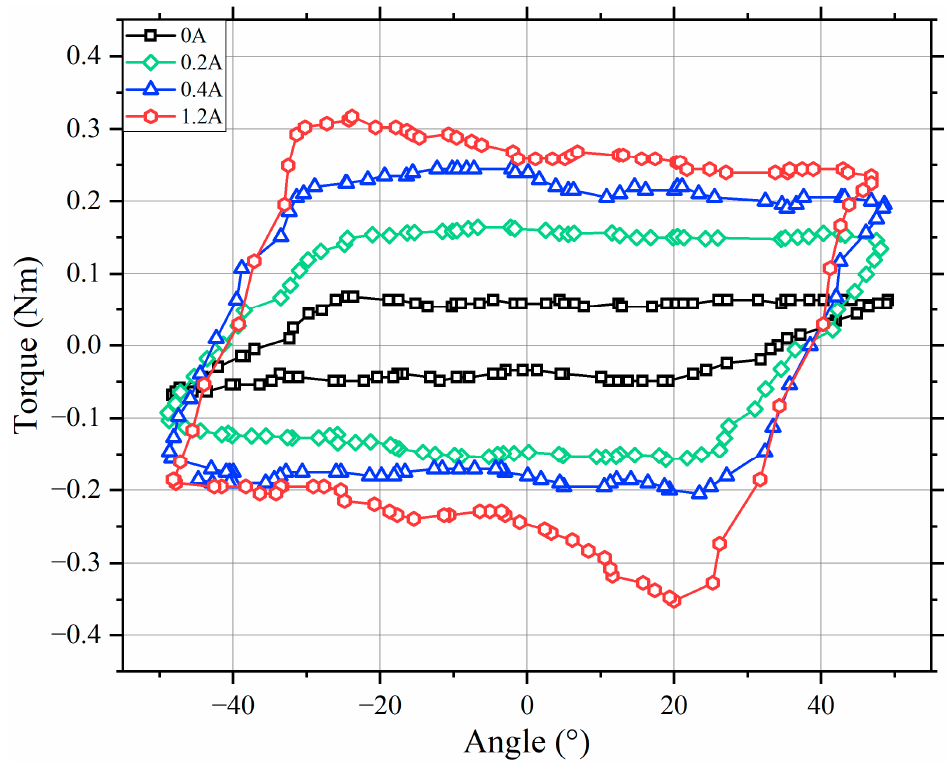
Figure 8. Torque–angle curve with different currents: the currents are 0 A, 0.2 A, 0.4 A, and 1.2 A. However, a defect in the designed MR damper appeared in the dynamic experiment.